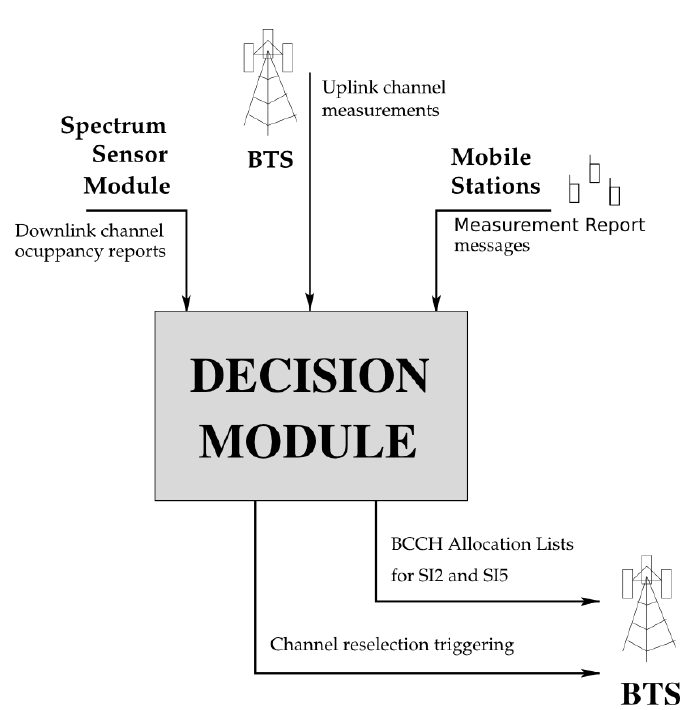
Figure 5. Decision Module.